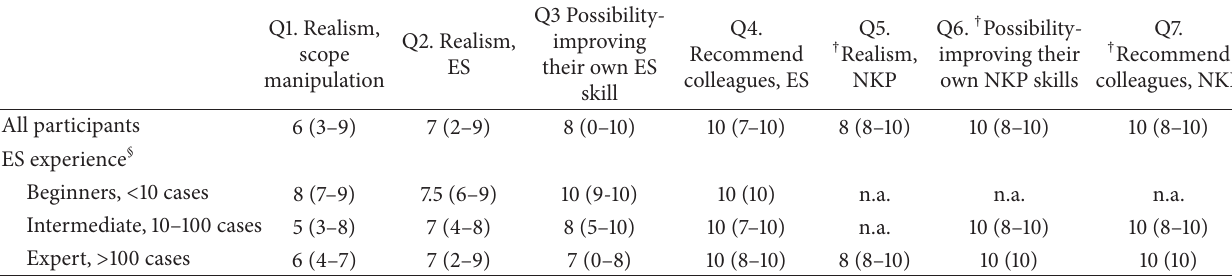
Table 3: Results of a questionnaire survey after hands-on